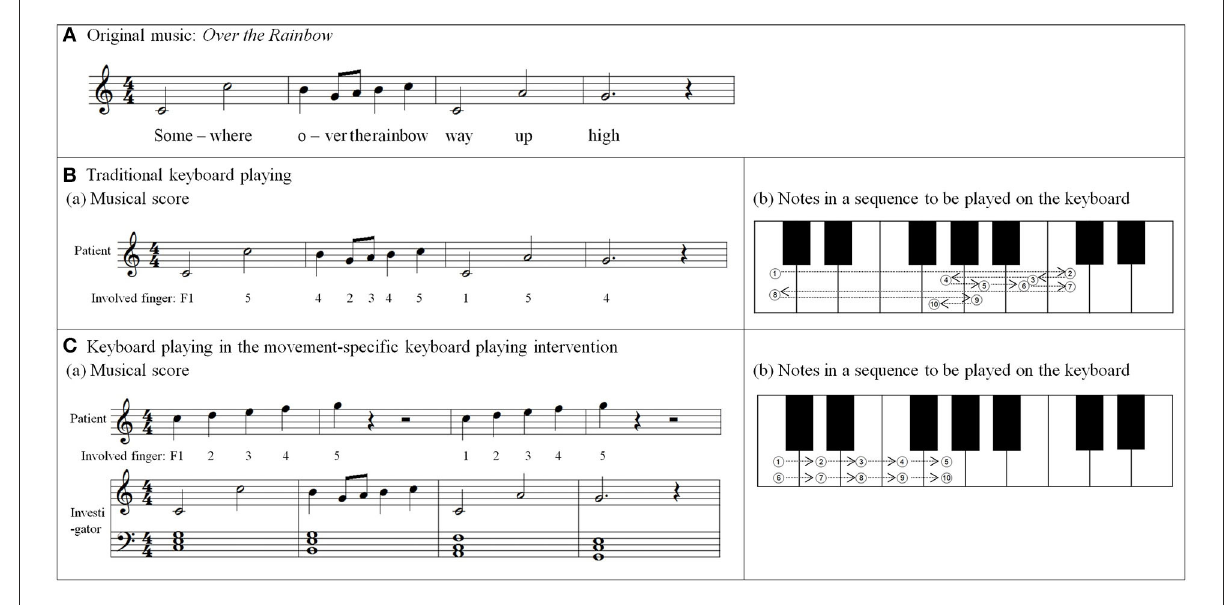
FIGURE2 (A–C) Structured keyboard playing notes in the movement-specific keyboard playing